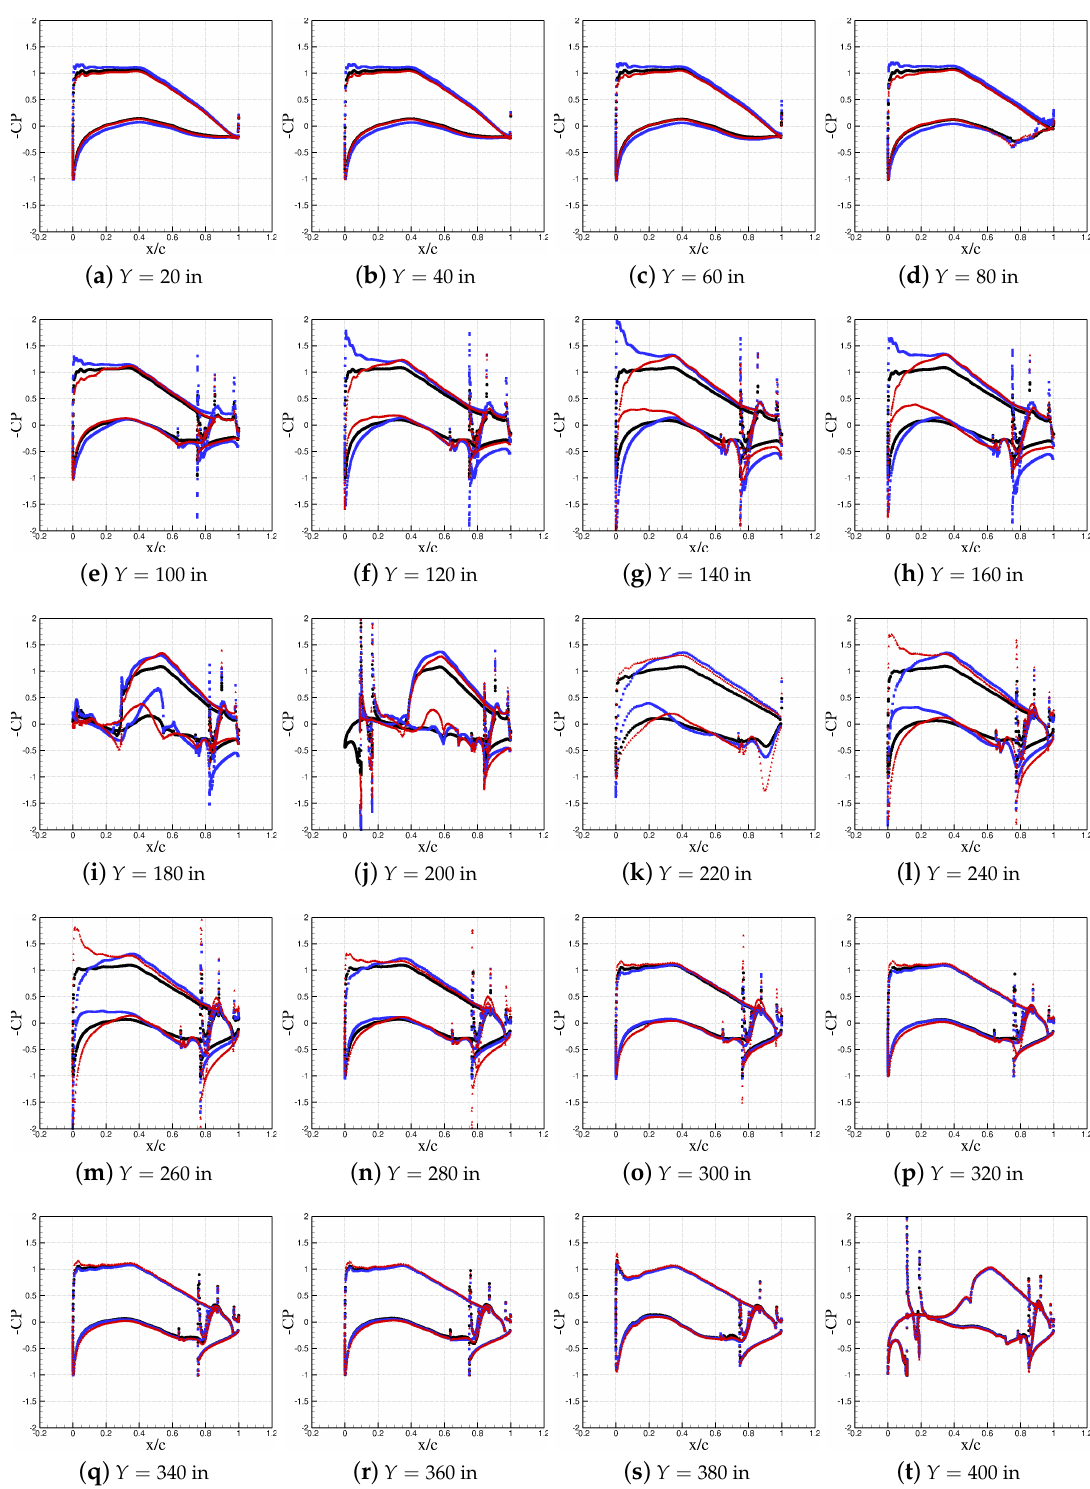
Figure 6. Pressure distribution ( − C p ) over the wing for wing only and wing with a prop mounted at inboard nacelle; the propeller spins counterclockwise and clockwise and has a 20-deg blade angle. Black dots show no prop. Blue-colored square markers show a propeller spinning counterclockwise. Red triangles show a propeller spinning clockwise. Pressure data are time-averaged for the final three seconds of